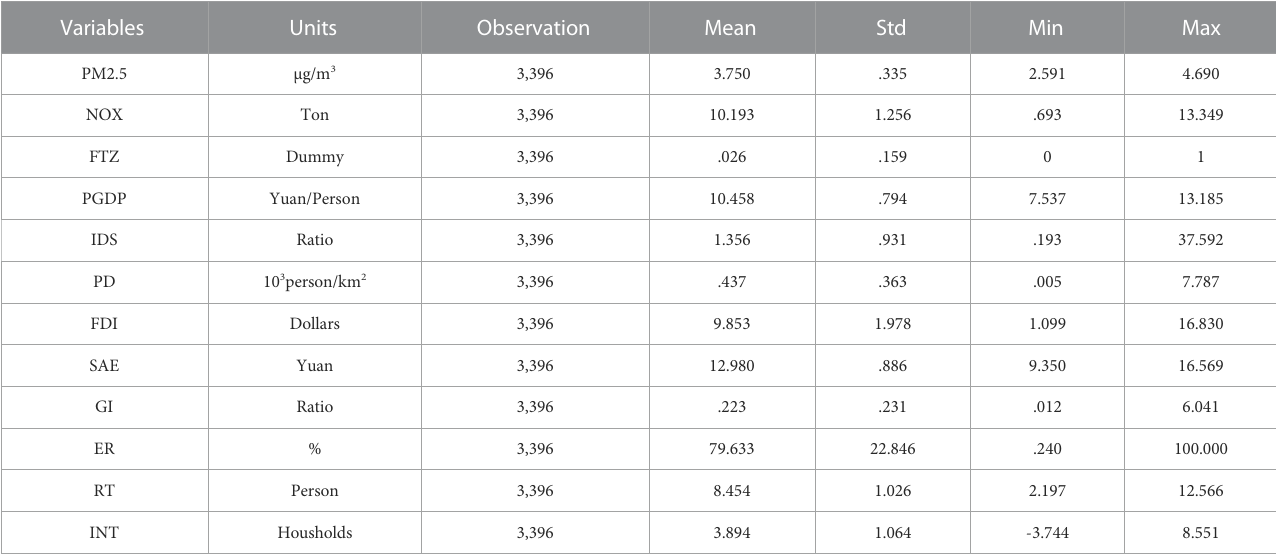
TABLE 2 Descriptive